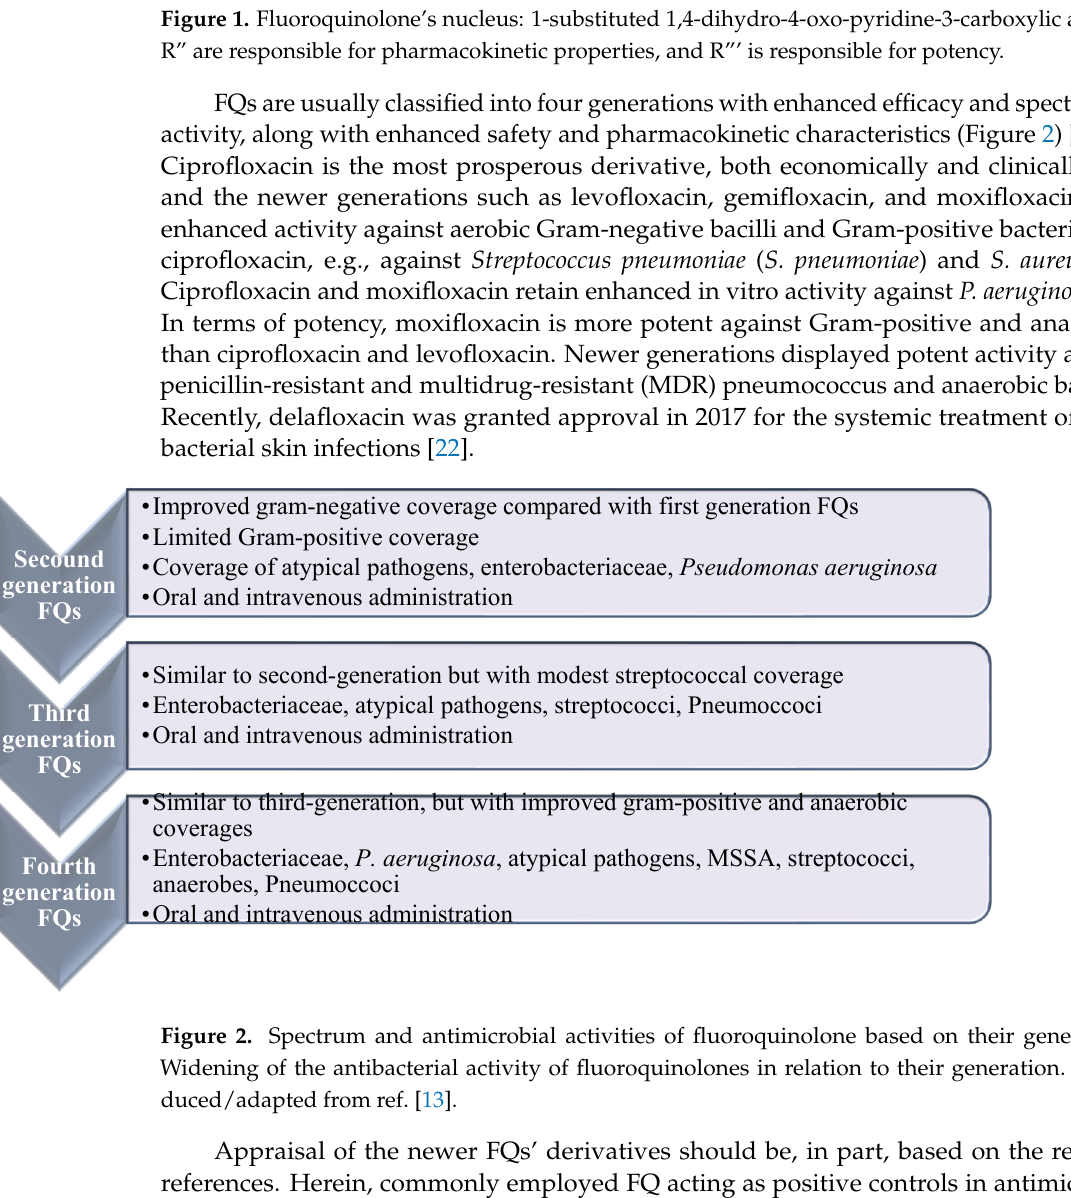
Figure 1. Fluoroquinolone’s nucleus: 1-substituted 1,4-dihydro-4-oxo-pyridine-3-carboxylic acid; R’,